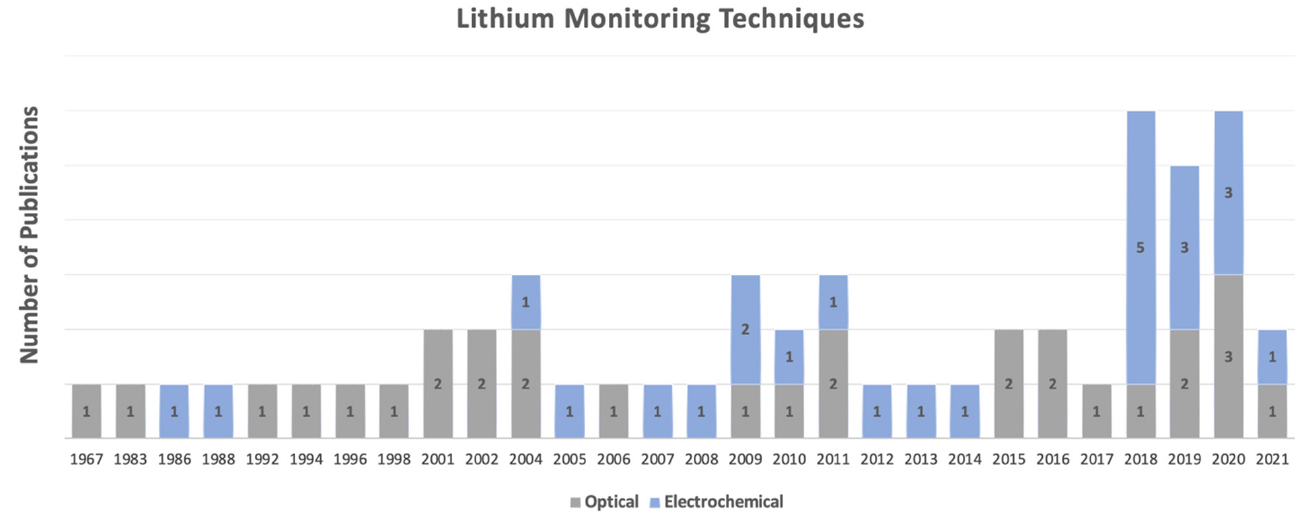
Figure 1. Diagram of the methodology used for the literature review process.